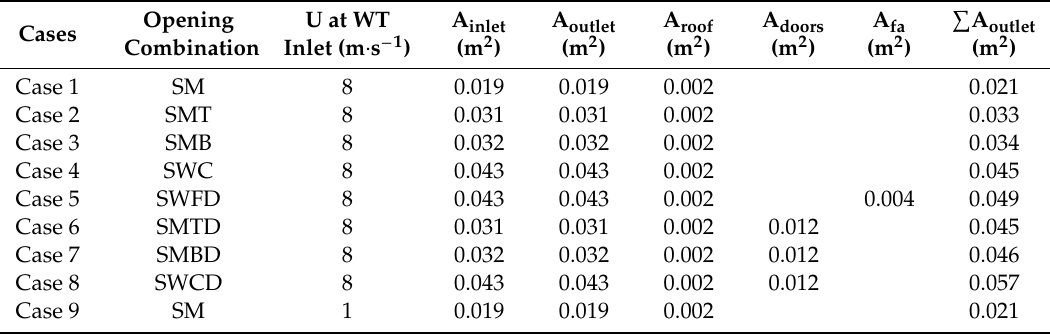
Table 1. Description of computational fluid dynamics (CFD) simulation cases. Cases 1 to 8 are the cases with eight opening combinations (as described in Figure 5) of NVD building using the wind tunnel inlet velocity of 8 m · s − 1 . Cases 9 to 18 are the cases with ten wind speeds with a constant opening configuration (i.e., SM-Middle part of side walls